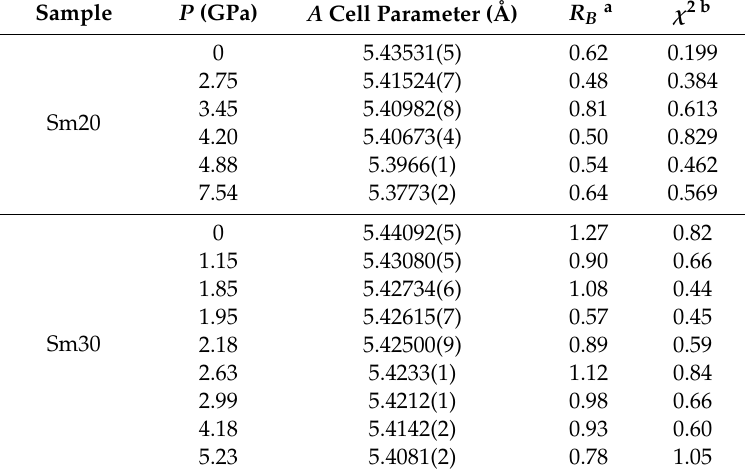
Table 2. Applied pressure, refined cell parameter and Rietveld agreement factors for each studied sample.